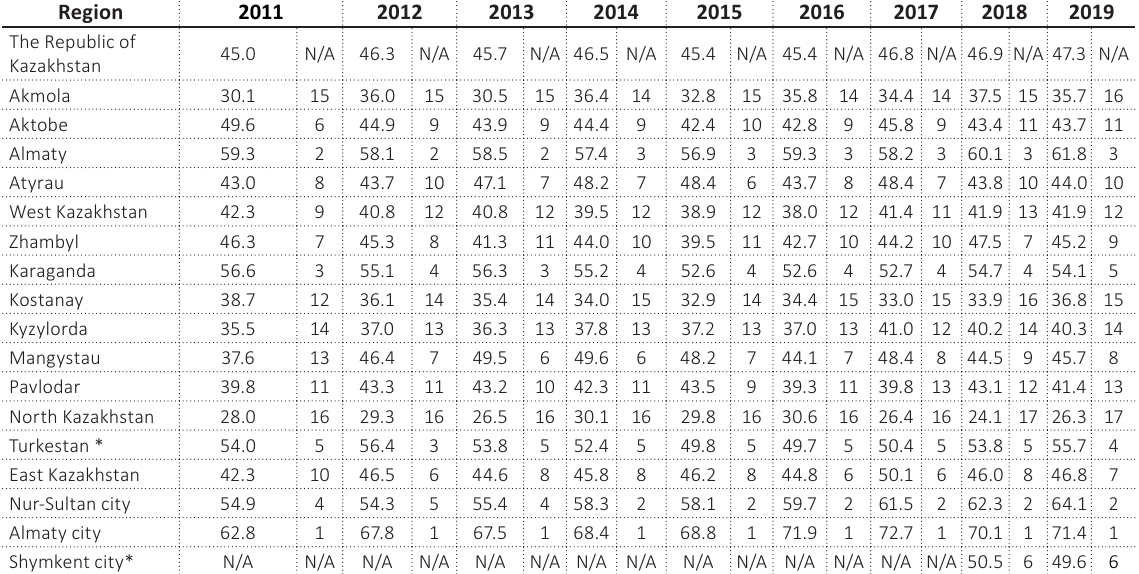
Table A3. Index and ranking of social development of Kazakhstani regions, 2011–2019